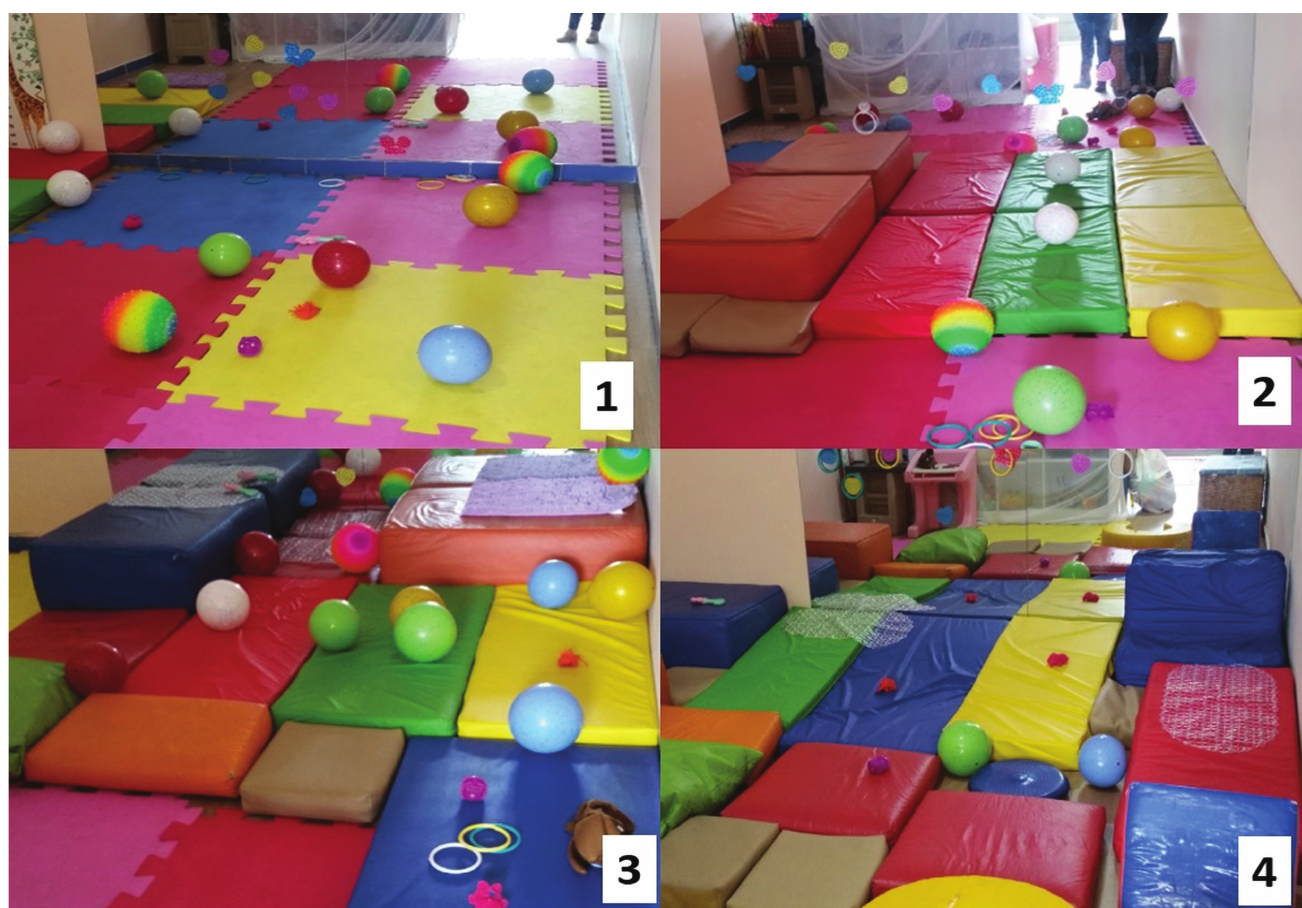
Figure 2. Examples of activities performed per week (1: firm surface, 2: soft surface, 3: different textures, 4: foam/sloped surface)